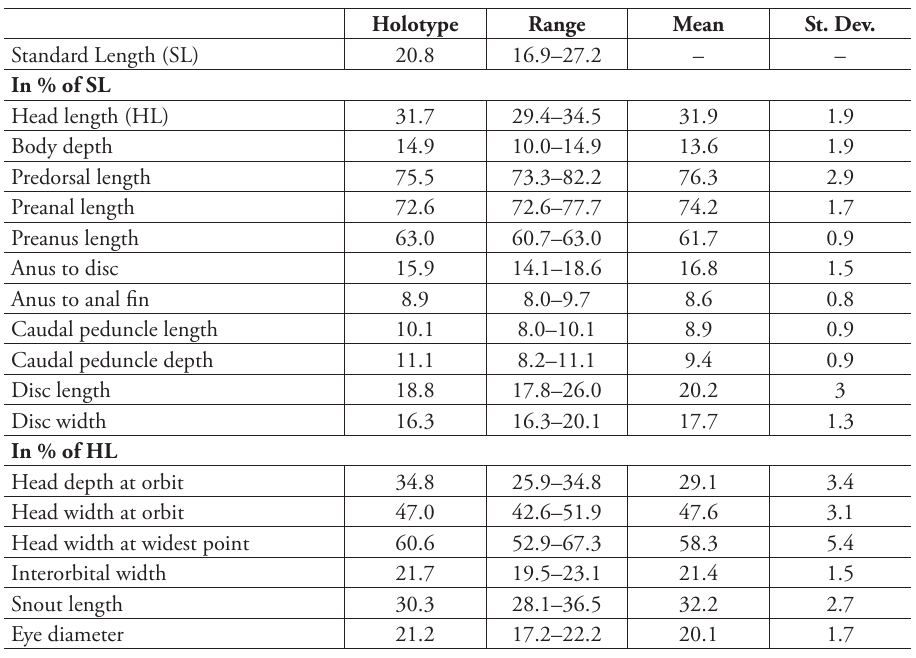
Table 1. Select morphometric characters obtained from the holotype and six paratypes of Flexor incus . Ranges include value obtained for